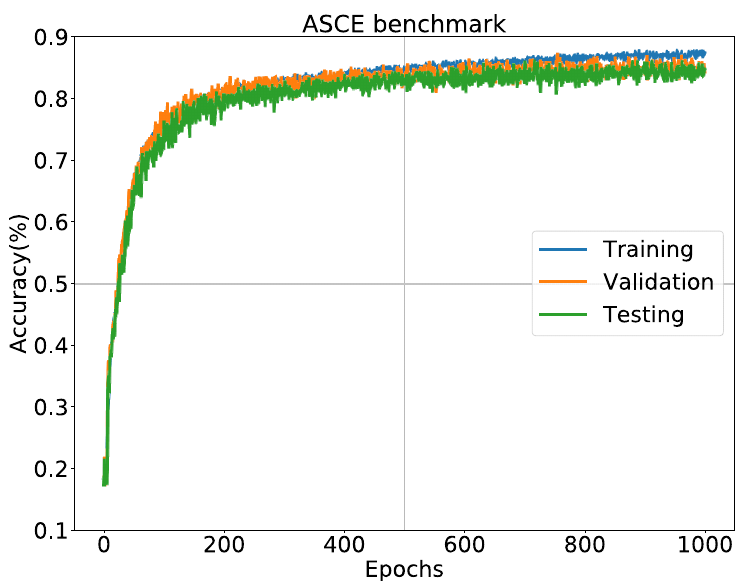
Figure 17. Confusion matrix of damage identification for Fold 4.